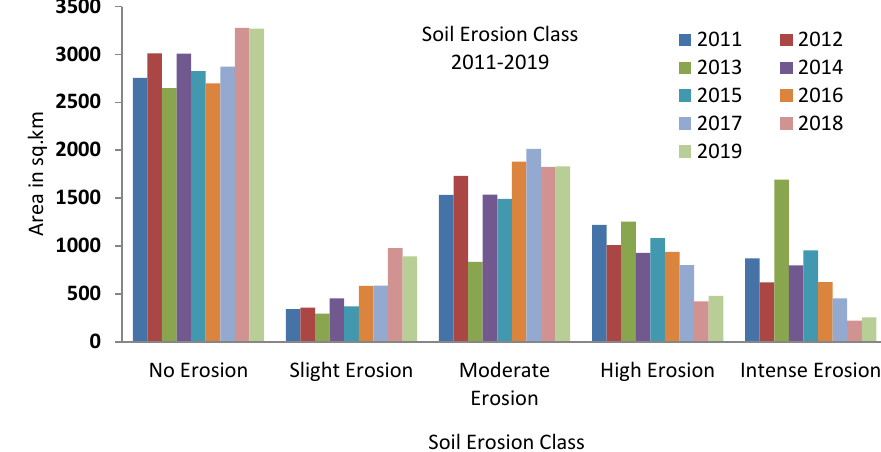
Fig. 2: Area under different soil erosion class in km 2 (2011-2019)